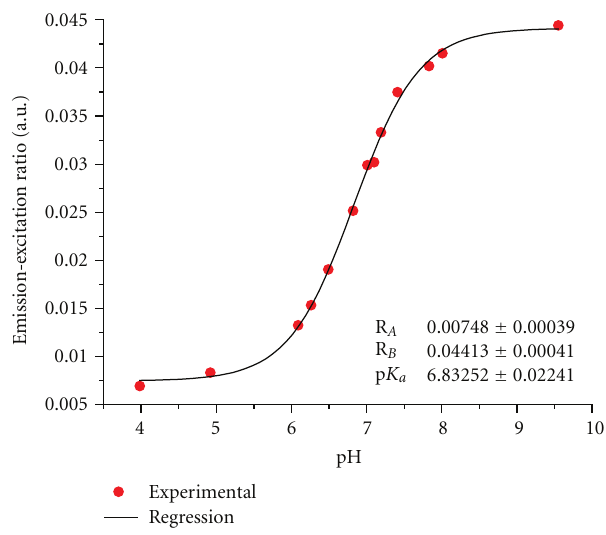
Figure 5: pH response from a crossed-fiber sensor junction using integrated emission-excitation ratios. Regression was performed with (1). Each experimental datapoint represents the average 300 laser excitation